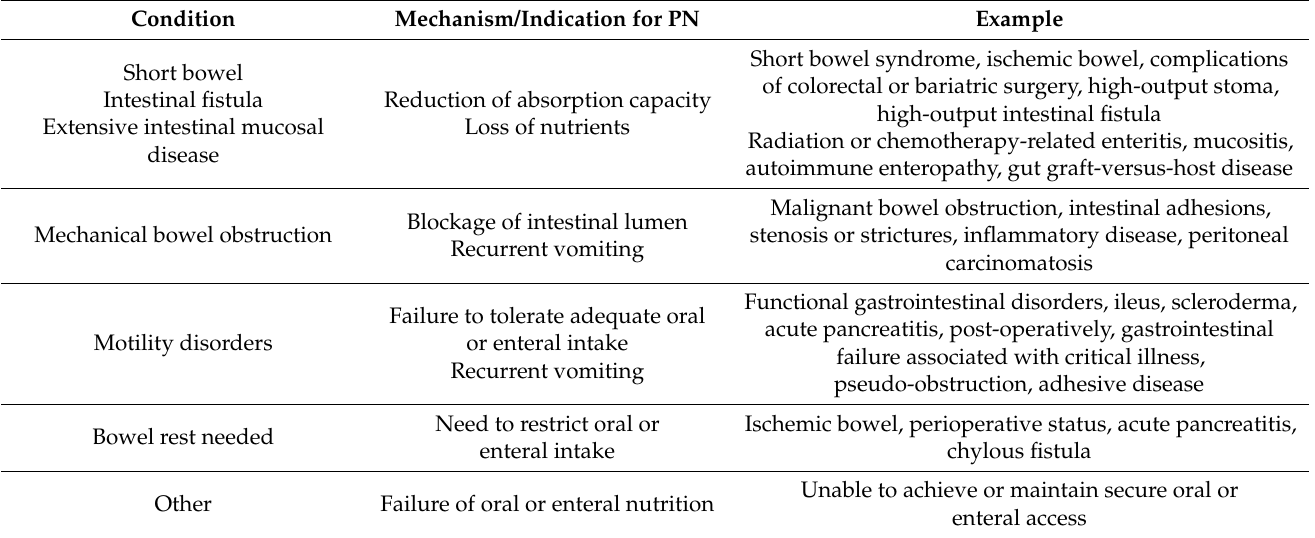
Table 1. Examples of clinical conditions requiring PN